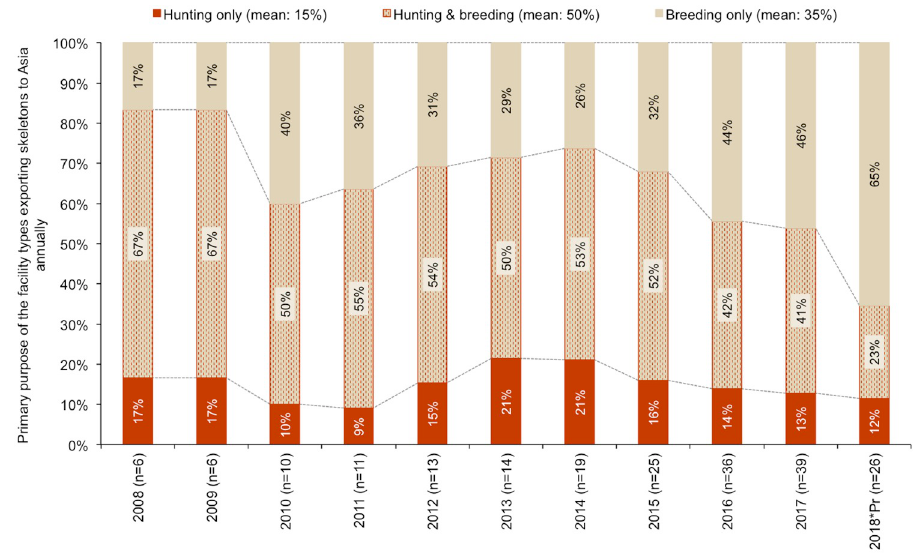
Fig 8. Primary purposes of the facilities exporting skeletons to Asia annually, based on hunting and breeding (sample size, n, after the year). Some facility purposes were documented as dual purpose (hunting and breeding), or a farmer owned a facility with a different purpose in a different province. Results correspond to Question 49.